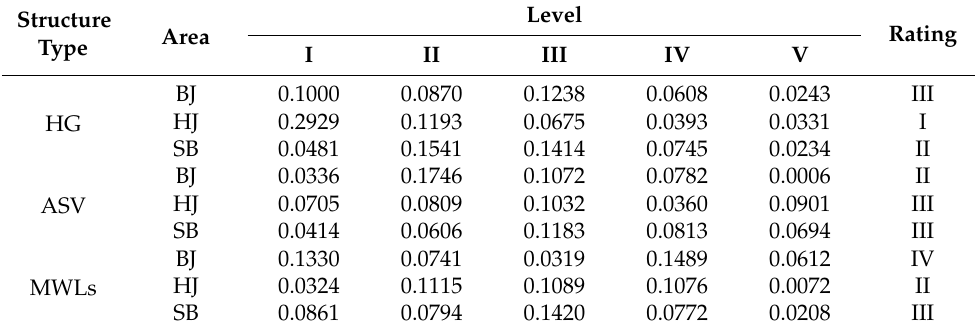
Table 3. Evaluation